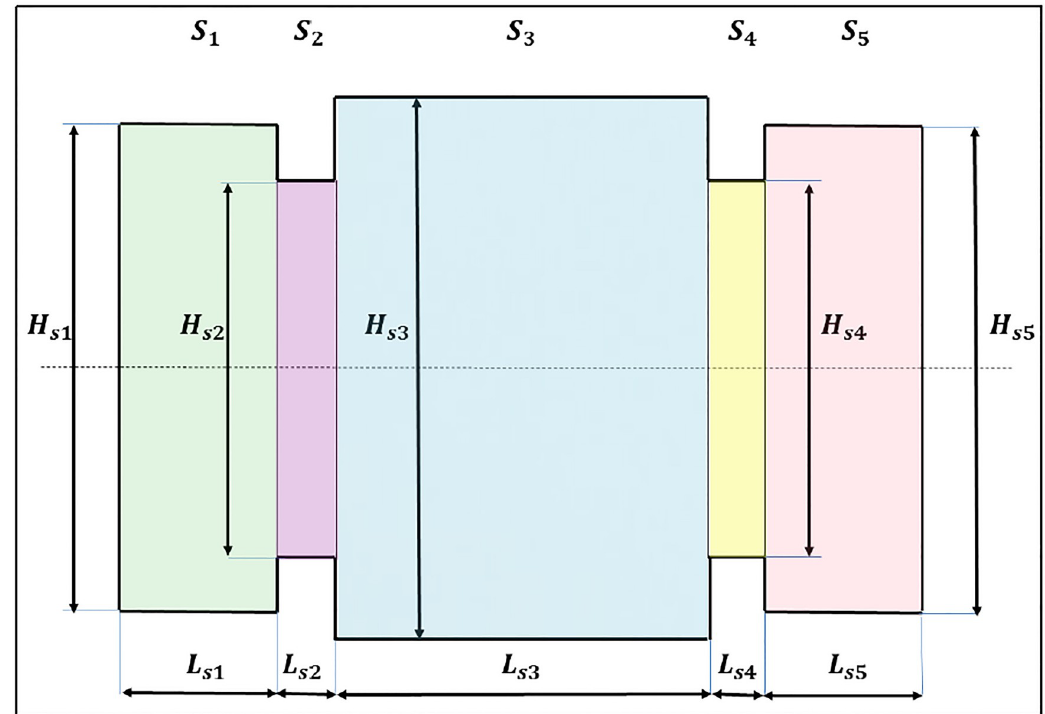
Fig 9. Vehicle modeled as multiple sections of the parallel sides of different dimensions but with the same